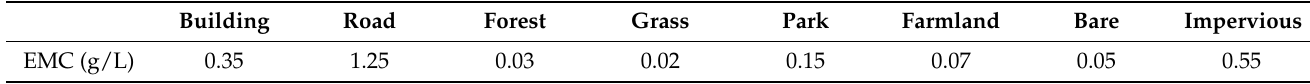
Table 2. Site suitability indices for